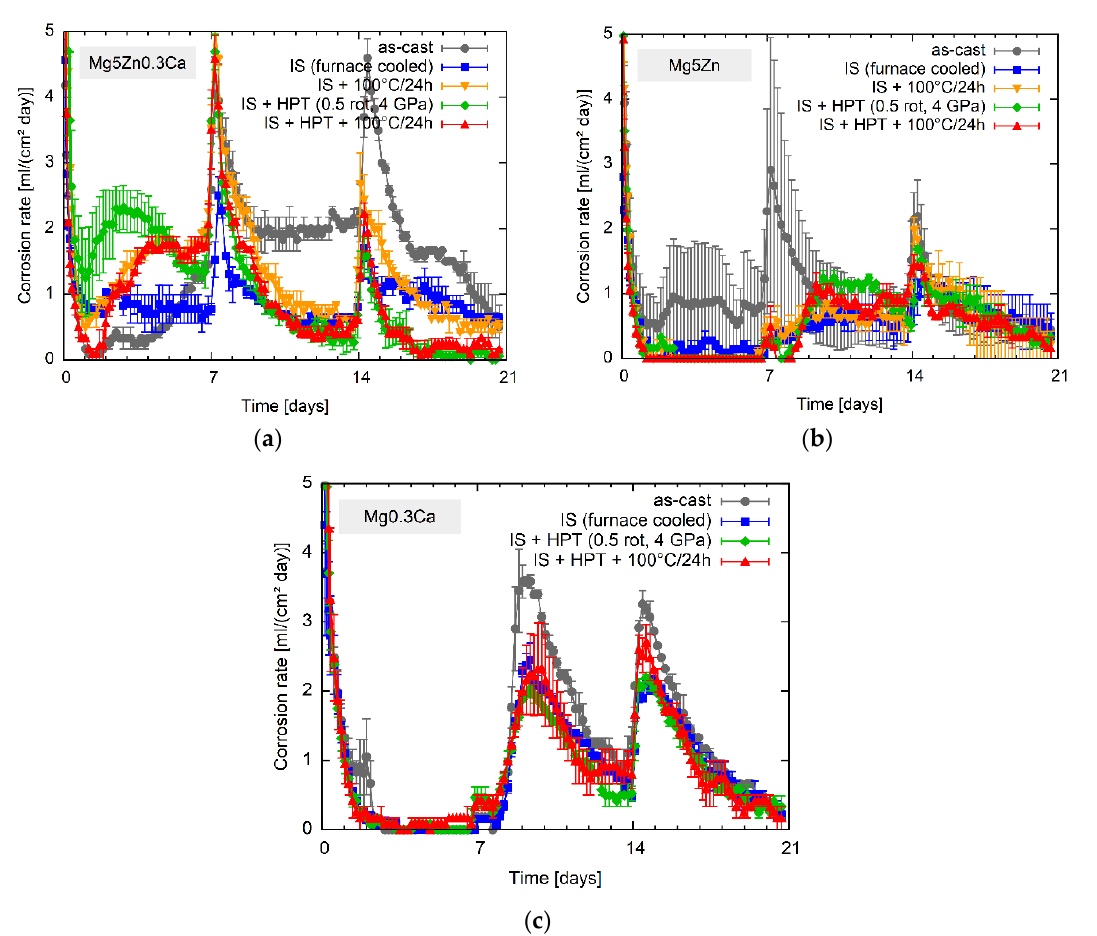
Figure 22. Corrosion rates of ( a ) Mg0.3Ca ( b ) Mg5Zn and ( c ) Mg5Zn0.3Ca in different conditions determined by immersion testing in simulated body fluid at body temperature. The SBF was renewed all 7 days.